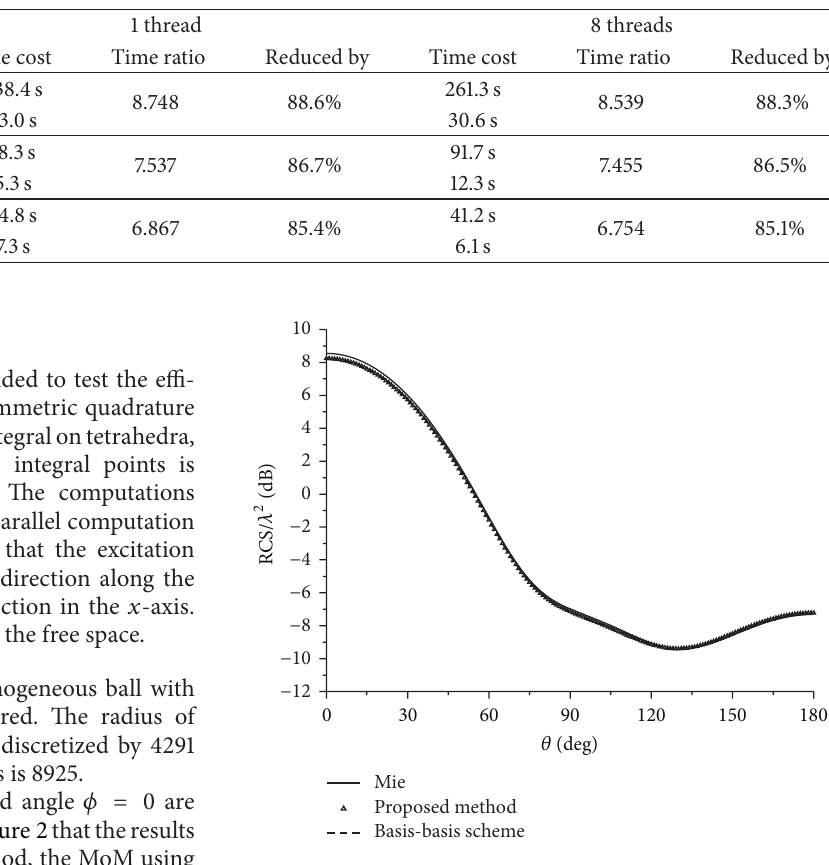
Table 1: The data from the three examples.